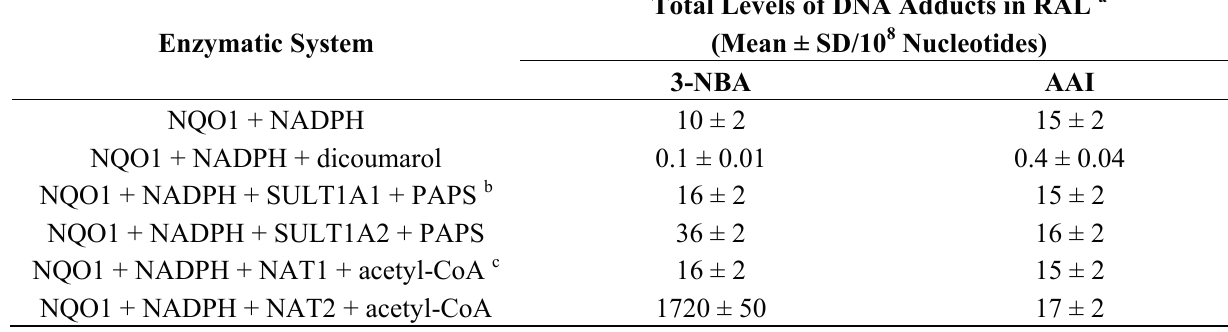
Table 1. DNA adduct formation by 1 μ M 3-NBA and AAI activated by human NQO1 and NATs (NAT1/2) and SULTs